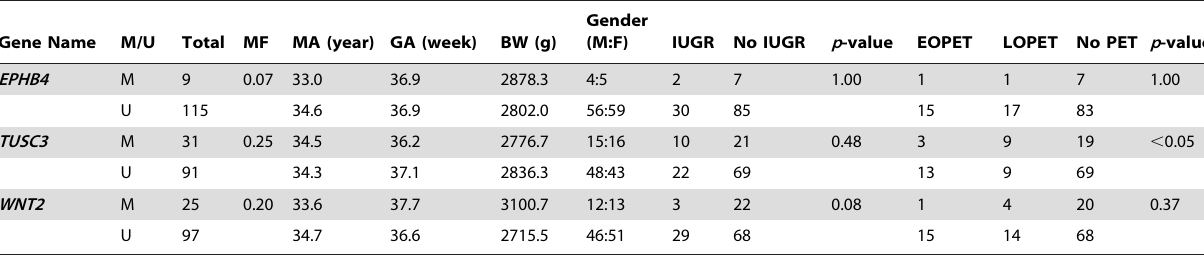
Table 1. Correlation between MAP and clinical status.